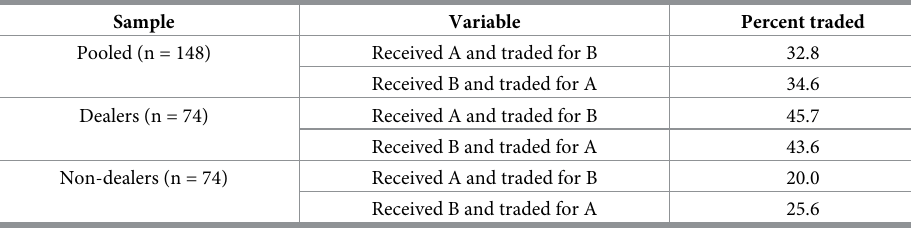
Table 6. Sample statistics from Experiment 1 in